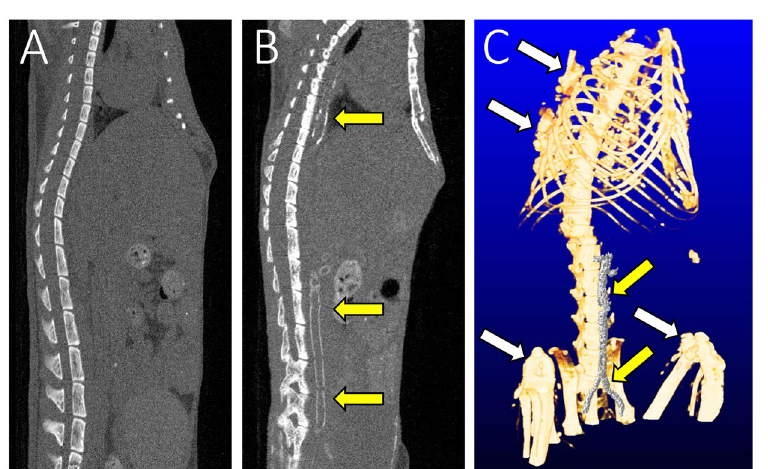
Figure 4. Representative computed tomography (CT) images of ectopic calcification. Positive ectopic calcifications were visible on CT images of CKD-HP (A6P6) mice in the thoracic and abdominal sections of the aorta ( B , C , yellow arrows), as well as the heart, kidney and soft tissues ( C , white arrows); no vascular calcification was observed in CKD-NP (A6) mice ( A